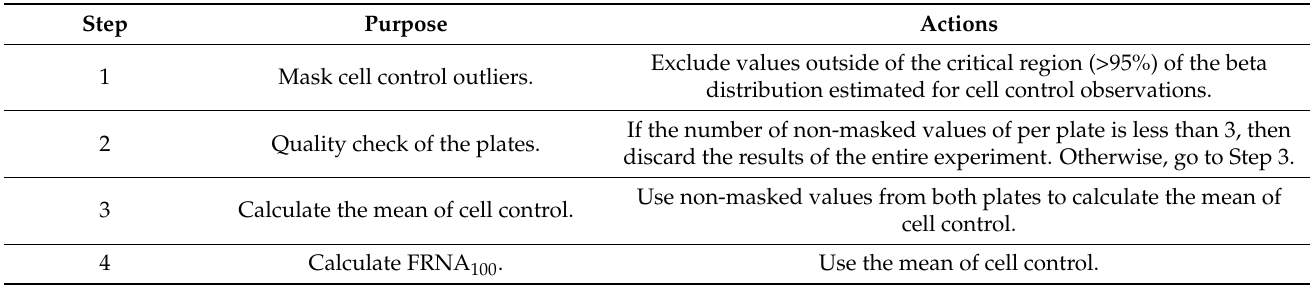
Table 3. Algorithm of handling experimental results for the cell control.